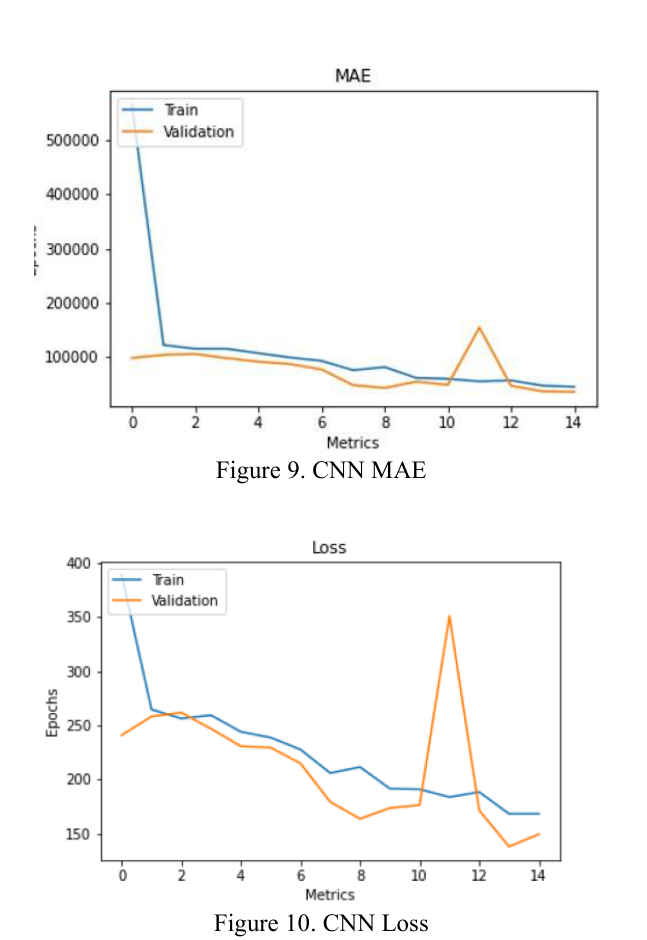
Figure 10. CNN Loss The forecasting of the open price of TATASTEEL using CNN model shows that its lags behind the CNN-LSTM and LSTM